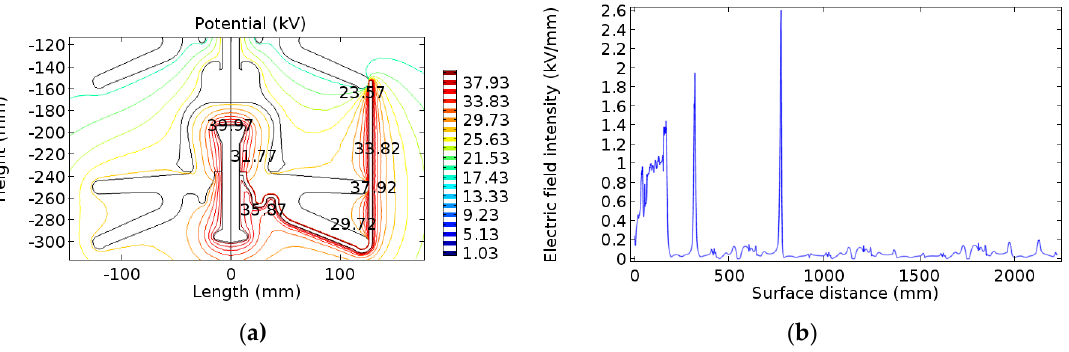
Figure 22. Simulation results of Bridge 2: ( a ) equipotential line distribution; ( b ) electric field distribution along insulator